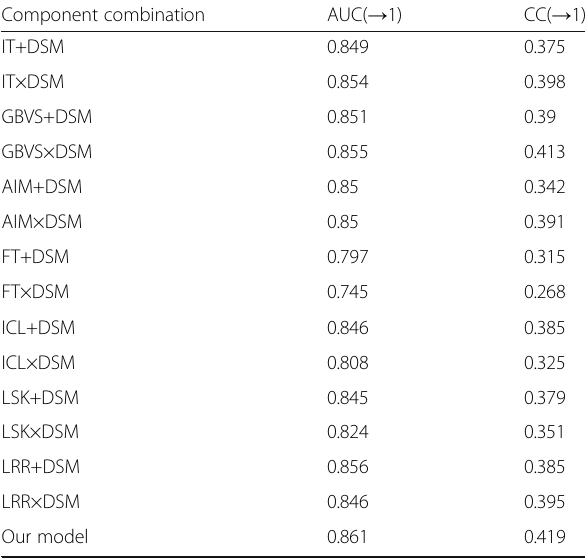
Table 4 Comparison between different 3D visual saliency prediction